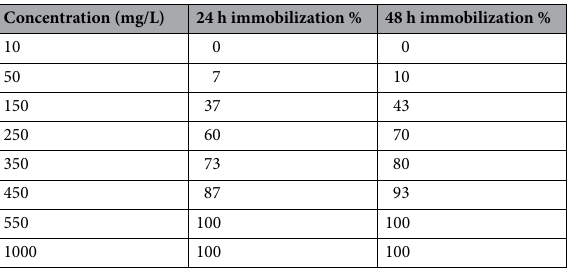
Table 1. Ostracods mean immobilization % after 24 and 48 h of exposure to different concentrations of PANI/ Ag (AMPSA)/GO QDs